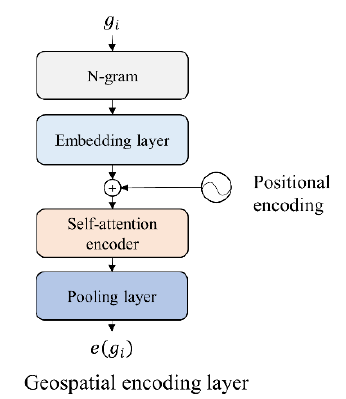
Figure 4. The geospatial encoding layer of